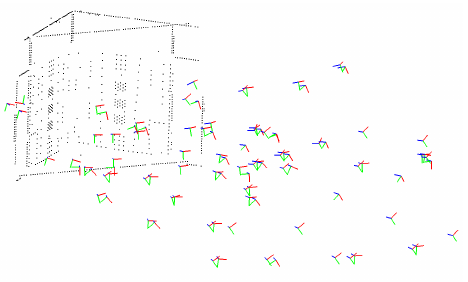
Figure 5. Sample image of the 3D calibration target.